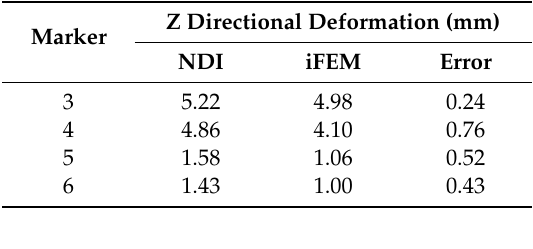
Table 4. The results of the markers deformation.